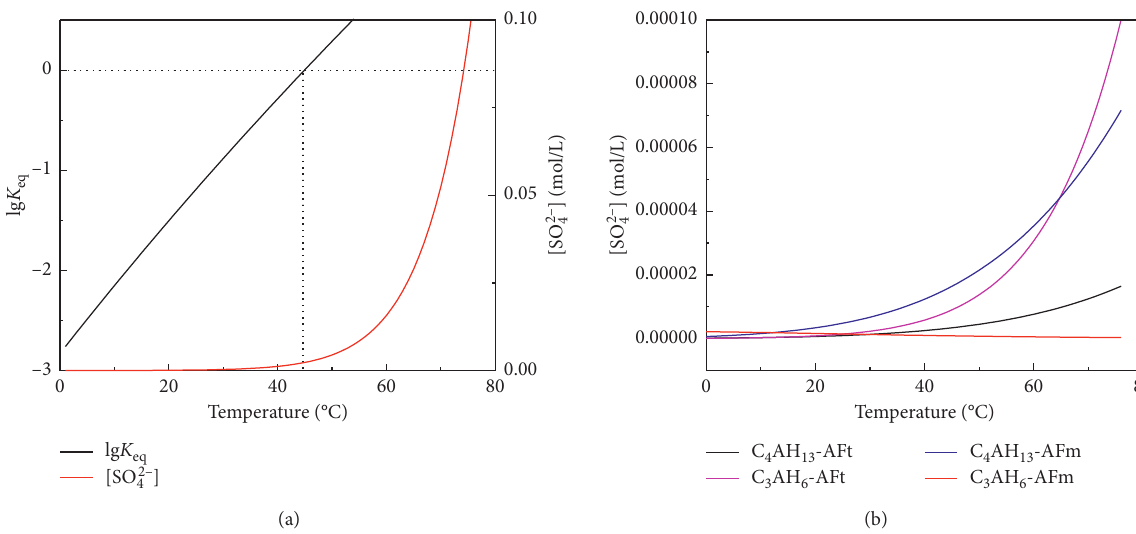
Figure 3: Variation curves of critical ions for different erosion products in system versus temperature. (a)CSCSH. (b) AFt and AFm.